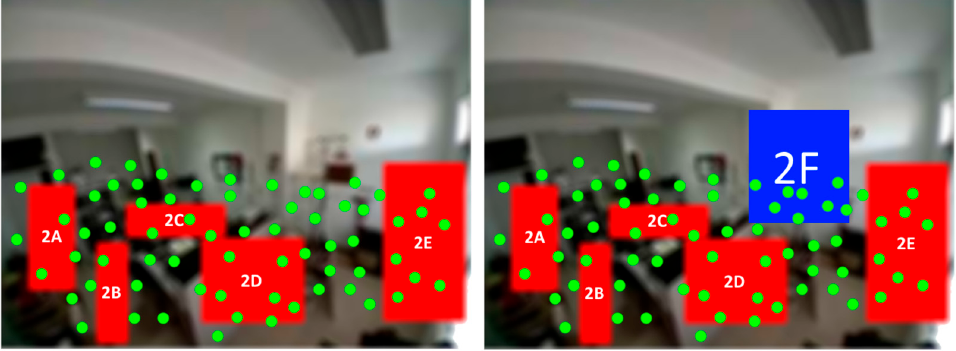
Figure 13. Hotspot’s